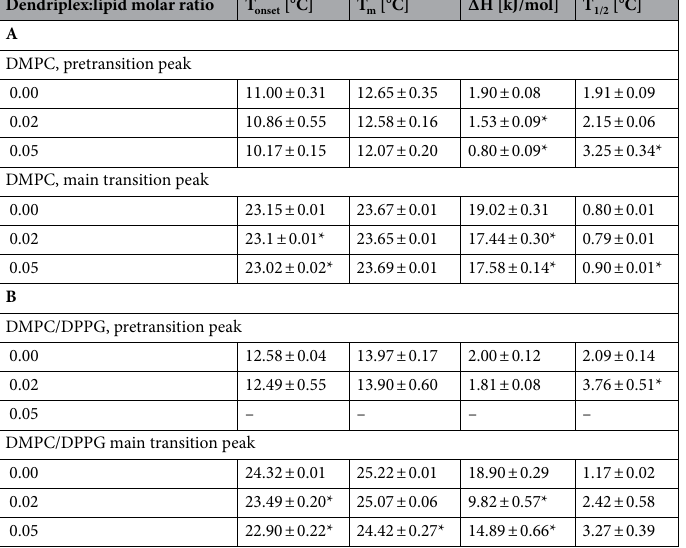
Table 1 present the thermotropic parameters of the peaks. The changes of thermotropic parameters of pre- transition peak (T